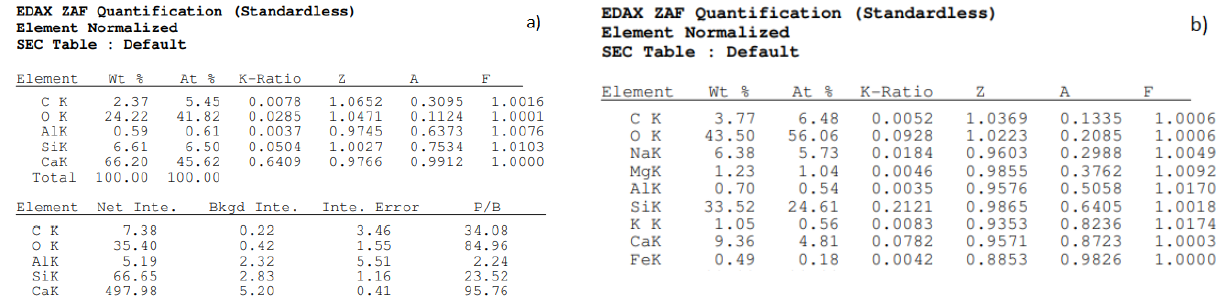
Figure 15. Photograph of the microstructure of silicate brick modified with glass sand and taken with the use of SEM; ( a ) gyrolite/natrolite — the figure shows systems in the form of flakes (1), thin sheets of ice that form into clusters, similar to gyrolite (1) or natrolite. ( b ) EDS spectrum glass sand modified silicate brick in point 1, visible Na as a component of glass sand and an element respon- sible for the crystallization toward gyrolite or natrolite.